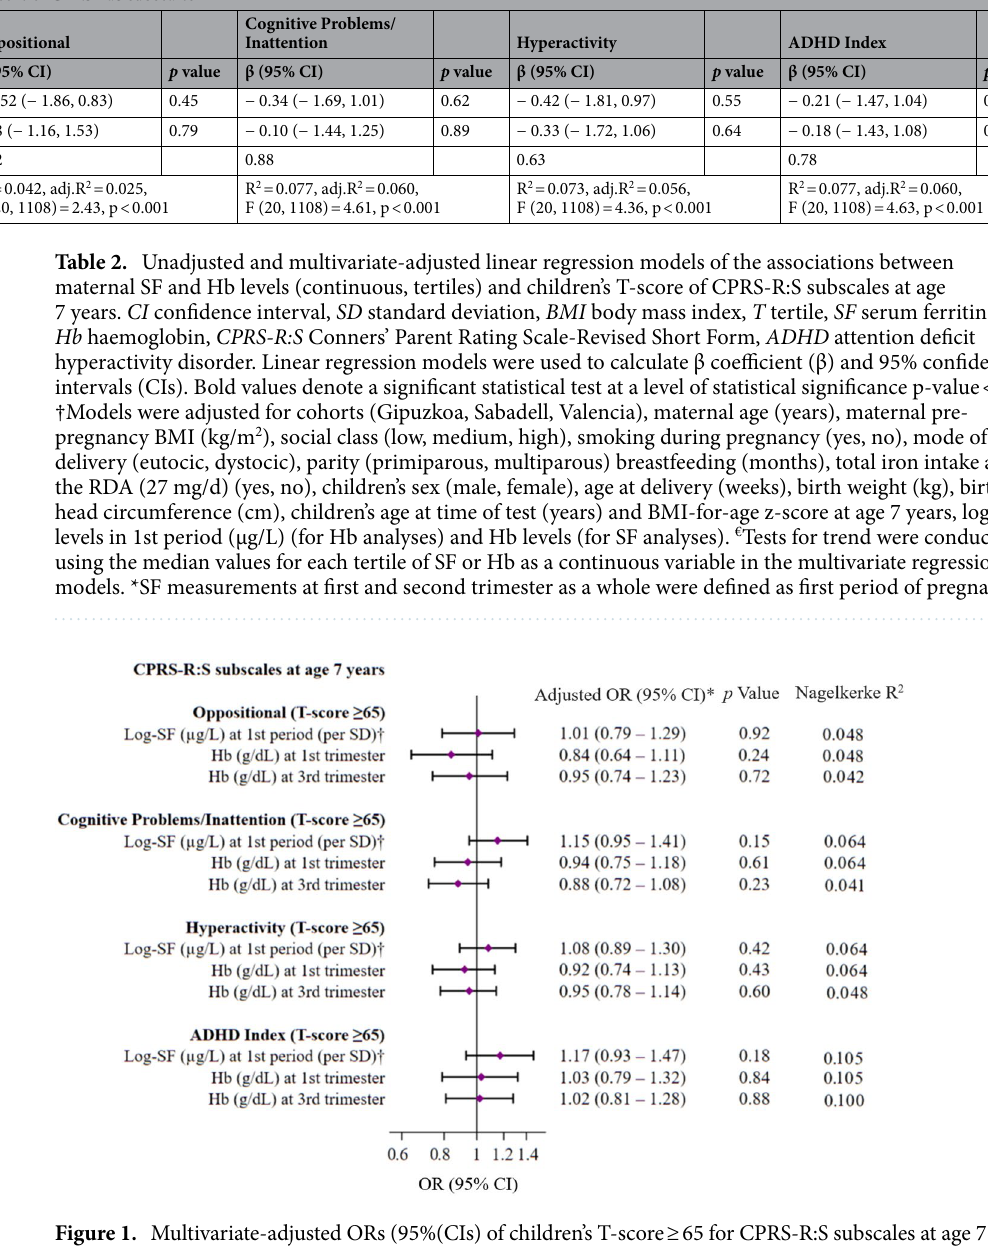
Figure 1. Multivariate-adjusted ORs (95%(CIs) of children’s T-score ≥ 65 for CPRS-R:S subscales at age 7 years associated with maternal log-SF and Hb levels (continuous). *Models were adjusted for cohorts (Gipuzkoa, Sabadell, Valencia), maternal age (years), maternal pre-pregnancy BMI (kg/m 2 ), social class (low, medium, high), smoking during pregnancy (yes, no), mode of delivery (eutocic, dystocic), parity (primiparous, multiparous) breastfeeding (months), total iron intake above the RDA (27 mg/d) in 2 nd period (yes, no), children’s sex (male, female), age at delivery (weeks), birth weight (kg), birth head circumference (cm), children’s age at time of test (years) and BMI-for-age z-score at age 7 years, log-SF levels in 1 st period (μg/L) (for Hb analyses) and Hb levels (for SF analyses). †FS measurements at first and second trimester as a whole were defined as first period of pregnancy. The diamonds represent OR and the whisker plots represent 95% CIs. BMI body mass index, SF serum ferritin, CPRS-R:S Conners’ Parent Rating Scale-Revised Short Form, ADHD attention deficit hyperactivity